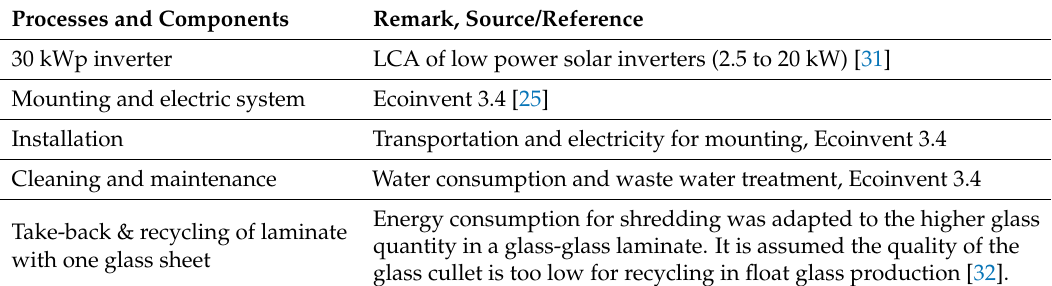
Table 4. Data sources for the elaboration of the life cycle inventory (LCI) for other processes and